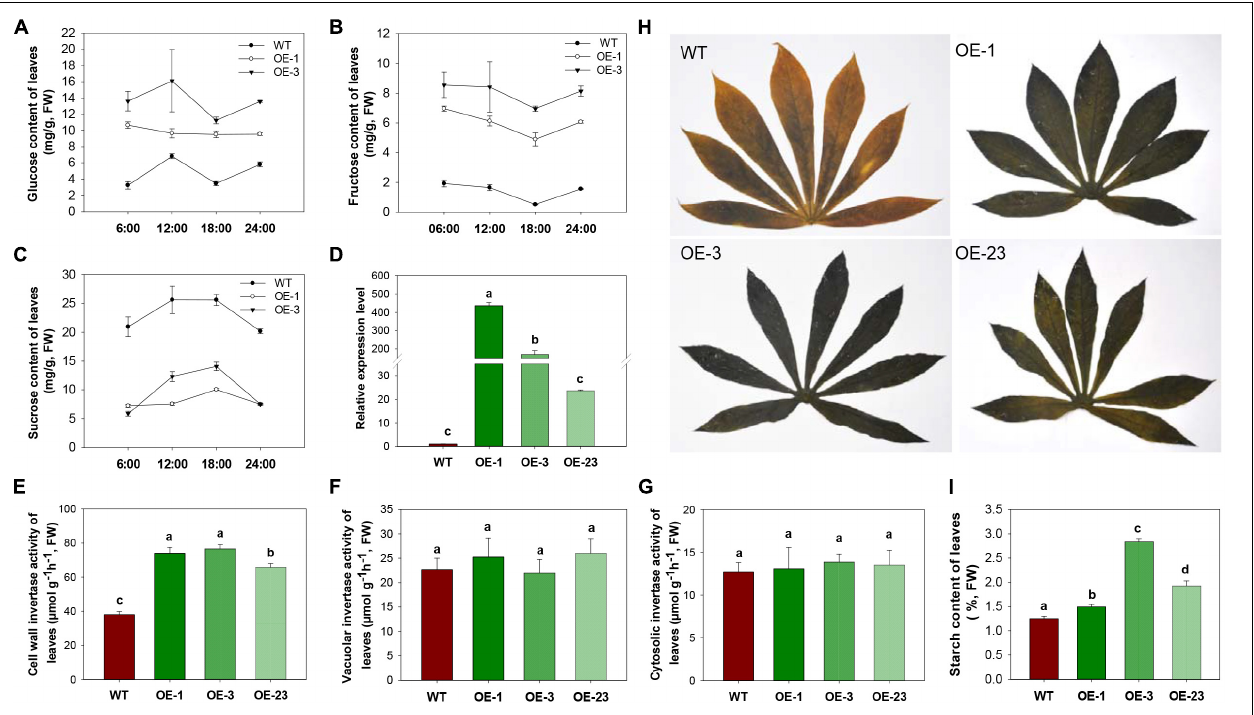
FIGURE 4 | INV activities, sugar contents and starch accumulation in leaves of wild-type (WT) and the MeCWINV3- overexpressed (OE) cassava plants. (A–C) Contents of glucose (A) , fructose (B) , and sucrose (C) under a day/night cycle. (D) Relative transcription level of MeCWINV3 . (E–G) The enzymatic activity assay of CWINV (E) , VINV (F) , and CINV (G) . (H,I) Iodine staining of leaves collected at 6:00 a.m. (H) and their total starch contents (I) . Different letters indicate significant differences (one-way ANOVA, p < 0.05).